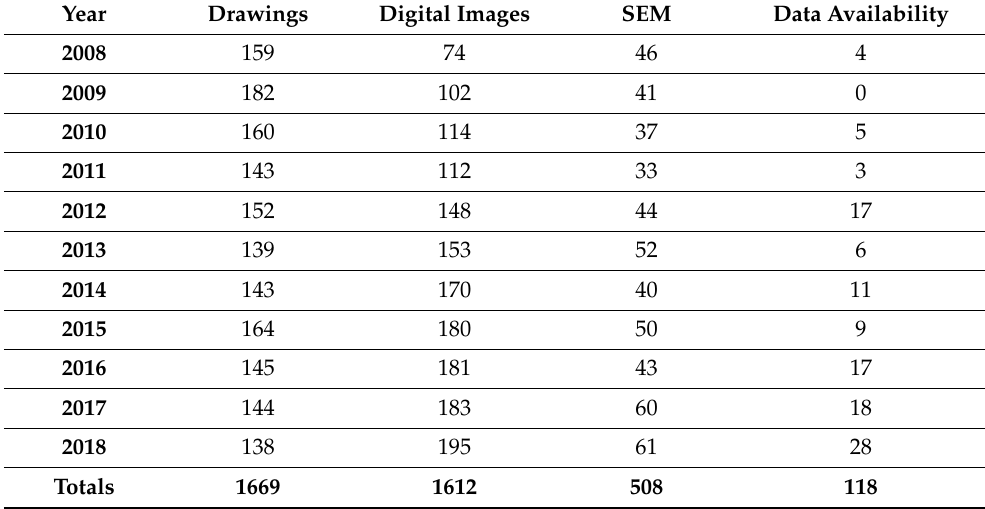
Table 3. The 2008–2018 summary data showing the type of imaging used to illustrate species and number of papers with electronic data available in a downloaded format.